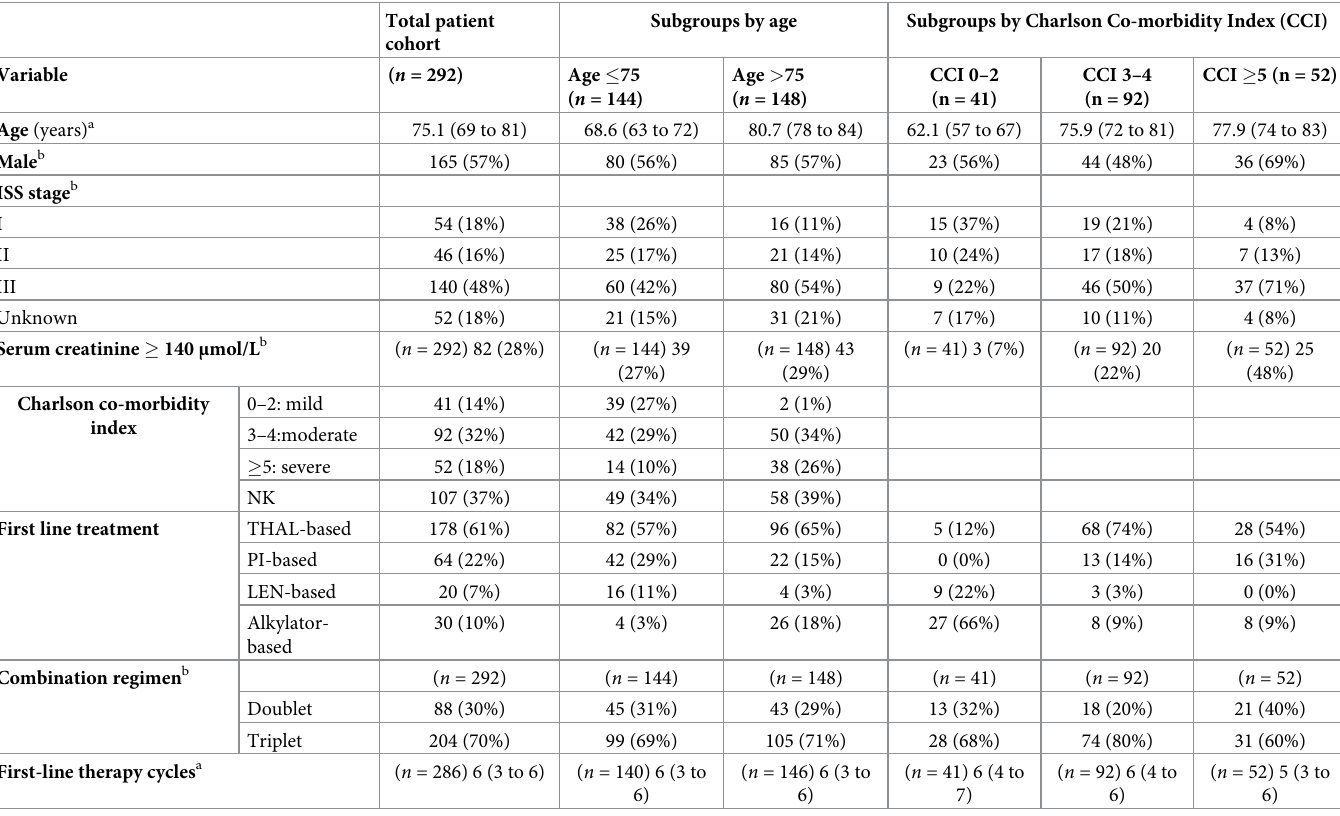
Table 1. Patient and clinical characteristics.